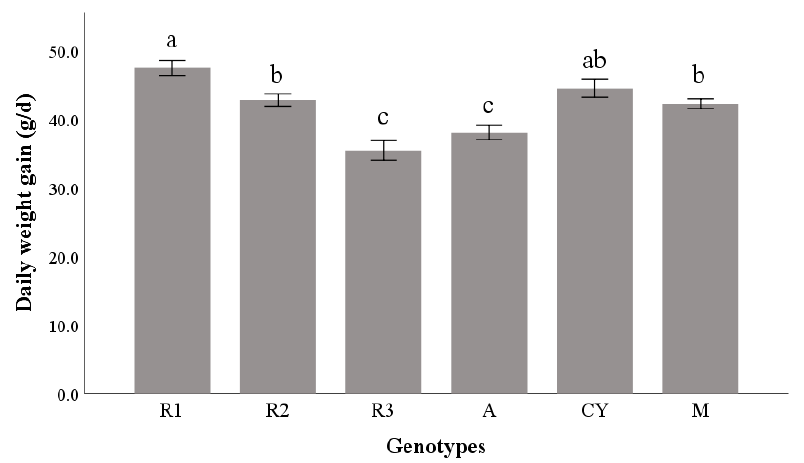
Figure 1. Daily weight gain (g/d) of six poultry genotypes on the entire rearing cycle. Abbreviations: R1 = Ranger Classic, R2 = Ranger Gold, R3 = Rowan Ranger, A = Hubbard Red JA, CY = CY Gen 5 × JA87, M = M22 × JA87. Bars not sharing any superscript letter are significantly different at p < 0.05 (Sidak correction).